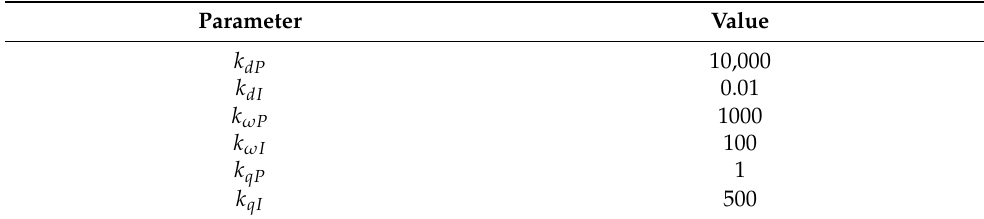
Table 3. Control gains for linear controller.